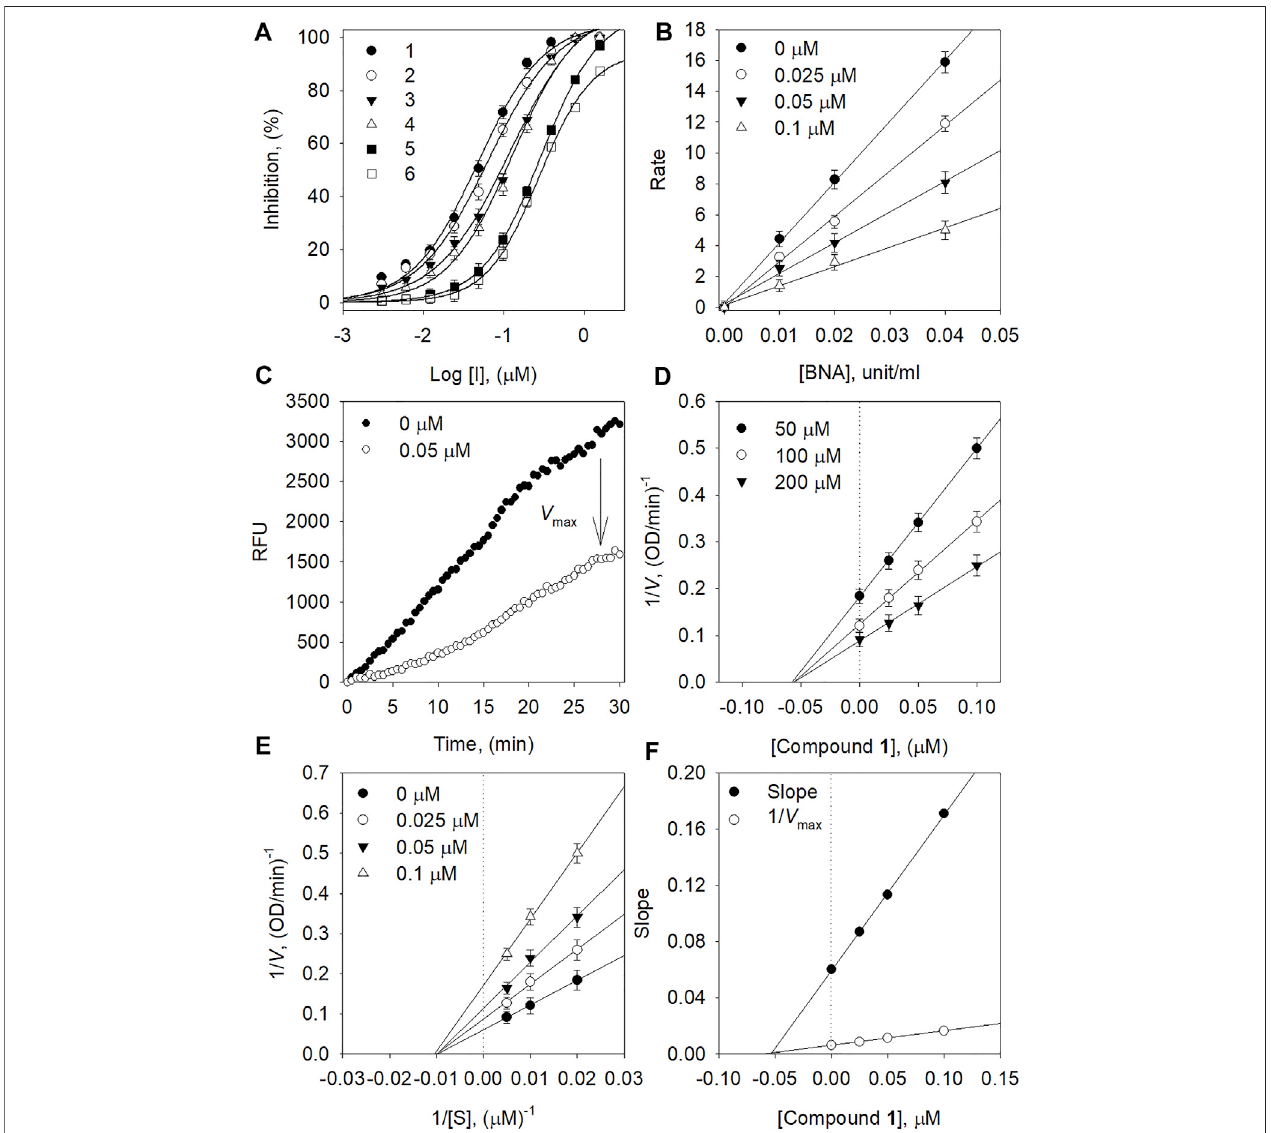
FIGURE 2 | (A) Dose-dependent inhibition effect of compounds on BNA (B) The catalytic activity of BNA as a function of enzyme concentration at different concentrations ofcompound 1 . (C) Inhibitioneffect ofthesubstrate byBNAwithand without 1.(D) Dixon plotsand (E) Lineweaver-Burk ofBNAinhibition ofcompound 1 . (F) Secondary plots of the Lineweaver – Burk plot, 1/ V max or slope vs . various concentrations of